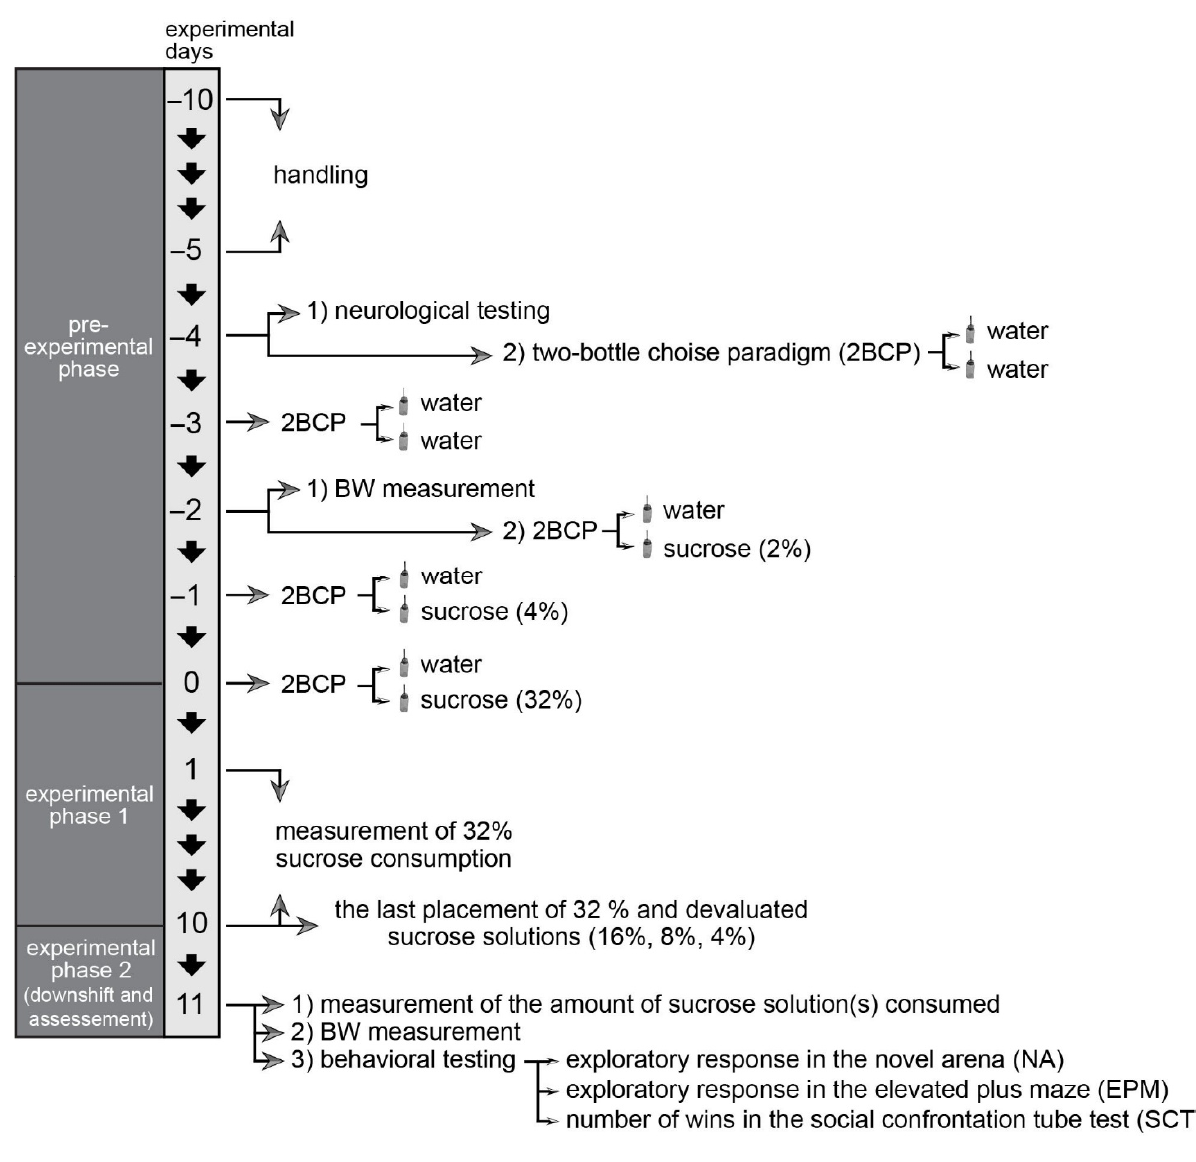
Figure 1. Schematic presentation of the experimental design. A day-by-day overview of the procedure is displayed with all undertaken steps and focal points of the experiment.